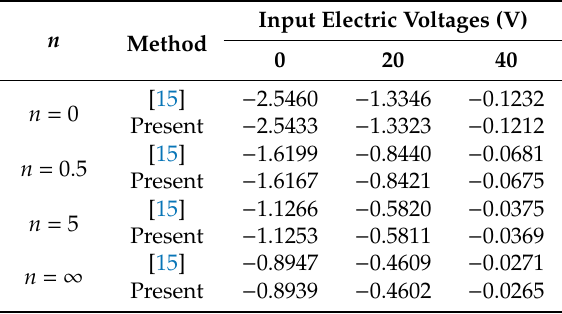
Figure 9. D eflection of a PFGP with different boundary conditions.